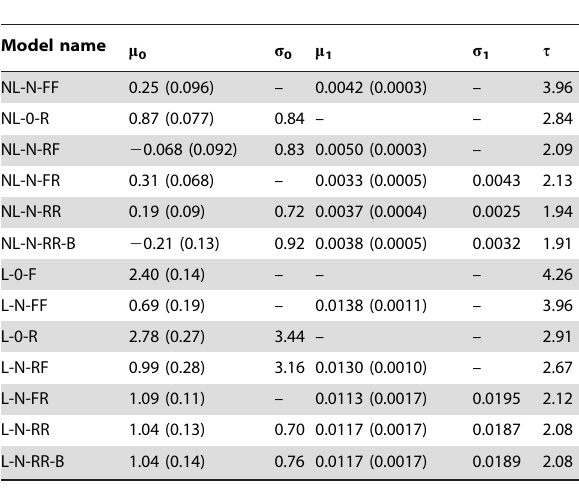
Table 3. Estimated values of the parameters of the 13